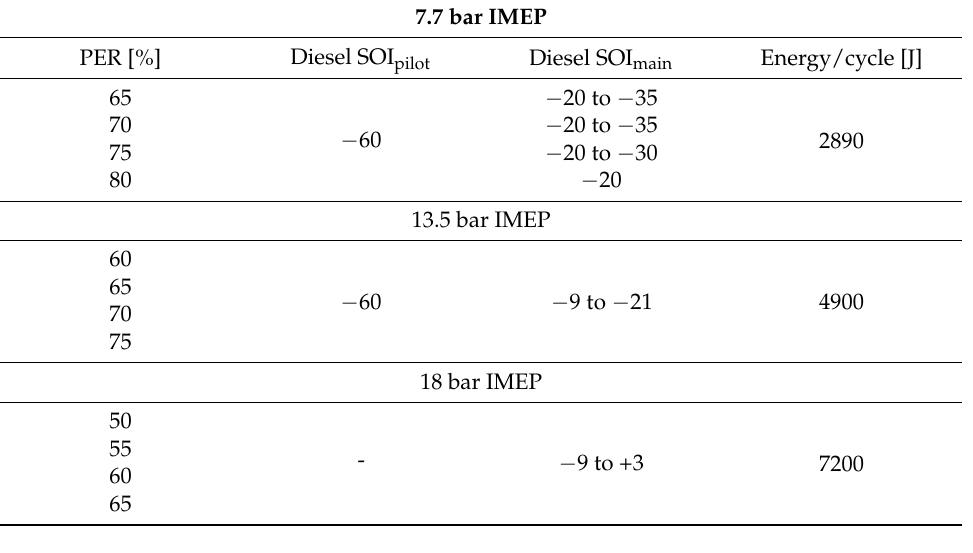
Table 7. Summary of all the tests performed to evaluate the three combinations of HRF +